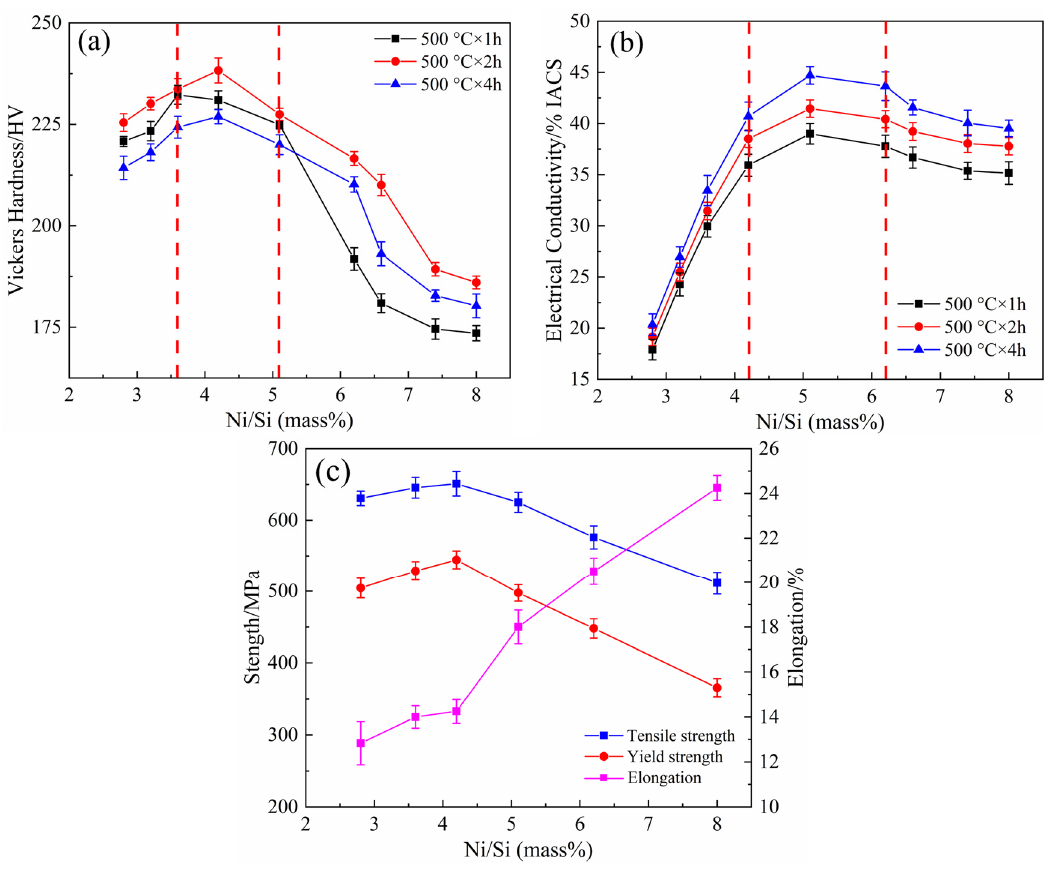
Figure 2. Mechanical properties and electrical conductivity of alloys with different Ni/Si mass ratios. ( a ) Hardness, ( b ) electrical conductivity and ( c ) tensile properties.